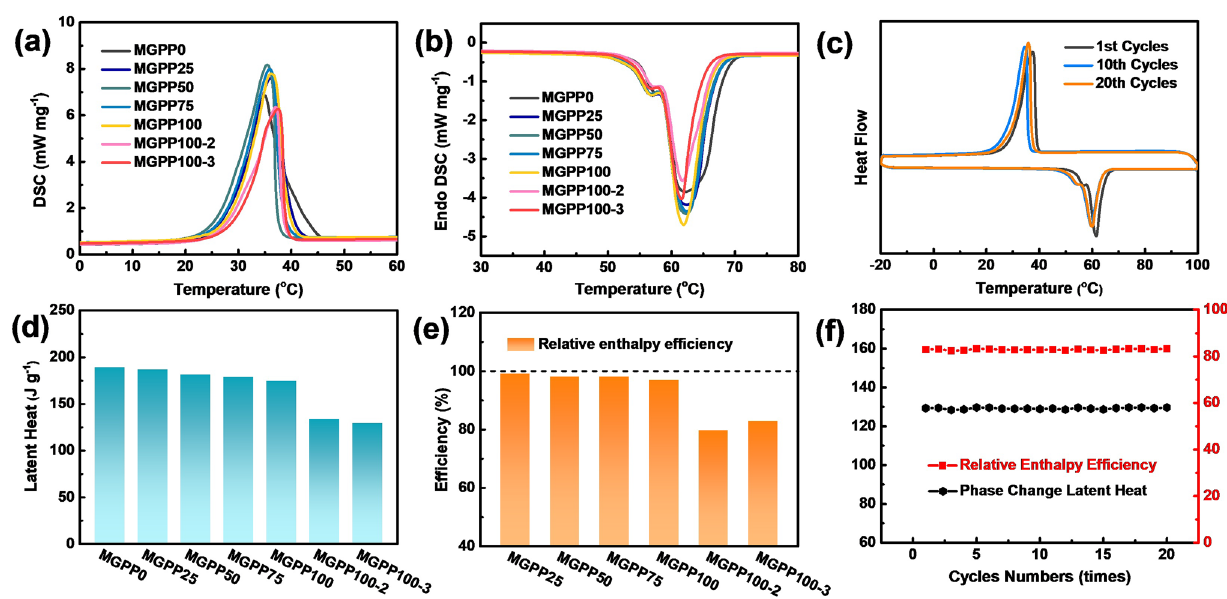
Fig. 5 a Cooling process and b heating process of DSC curves of MGPP composites. c DSC curves of MGPP100-3 with different numbers of thermal cycles. d Phase change latent heat and e relative enthalpy efficiency of MGPP composites. f Phase change latent heat and relative enthalpy efficiency of MGPP100-3 with different numbers of thermal